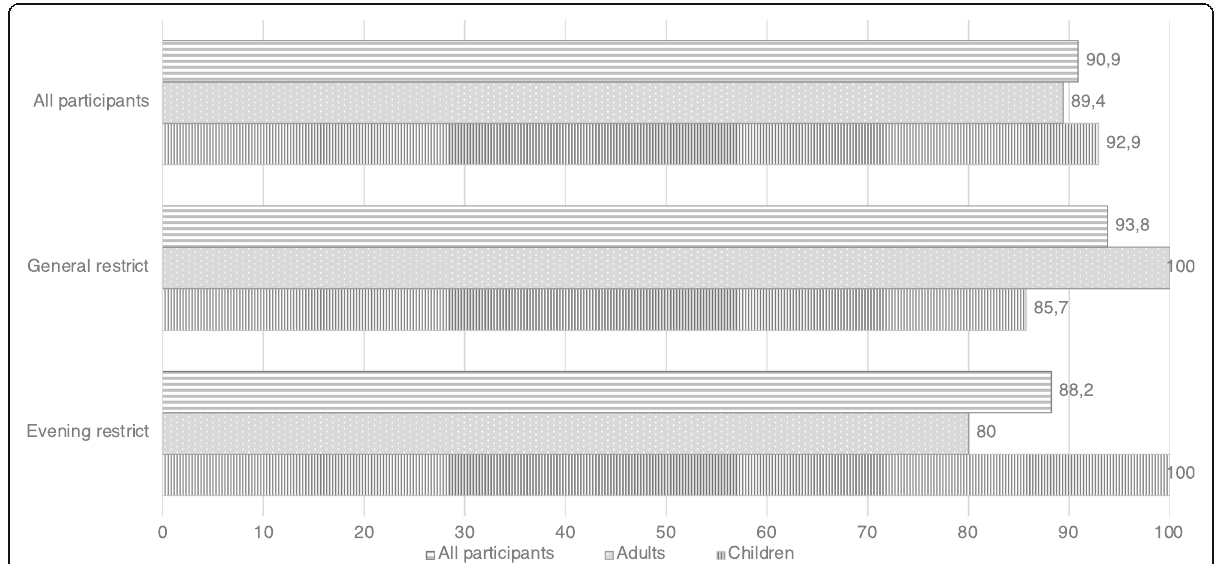
Fig. 4 Proportion of compliant participants. The figure illustrates the proportion of participants who were compliant to the sleep assessment protocol. Results are shown for all participants and for each intervention